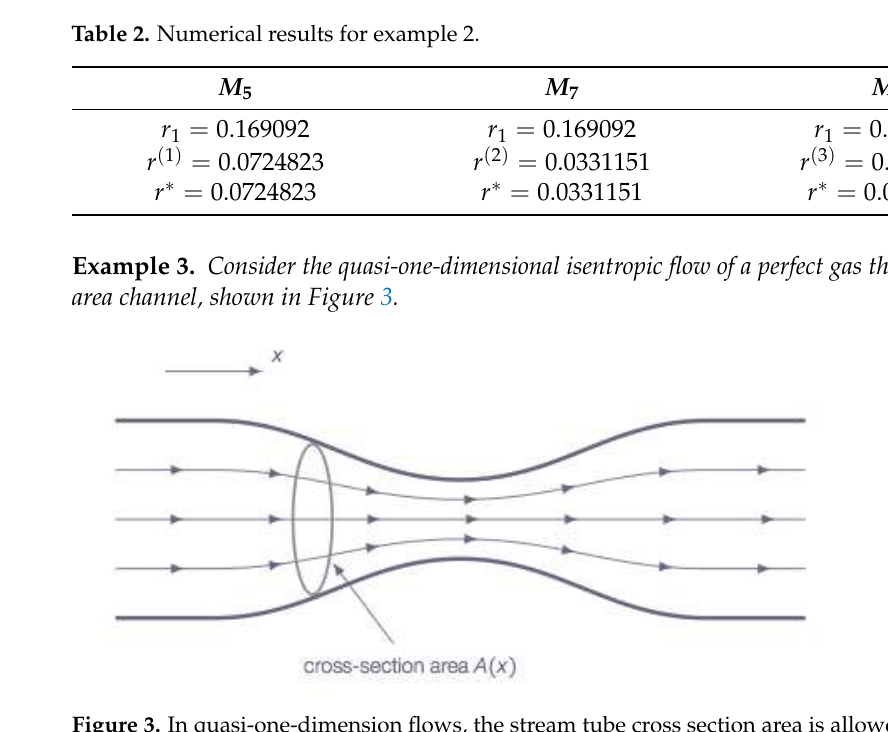
Figure 3. In quasi-one-dimension flows, the stream tube cross section area is allowed to vary in one direction A = A ( x ) .